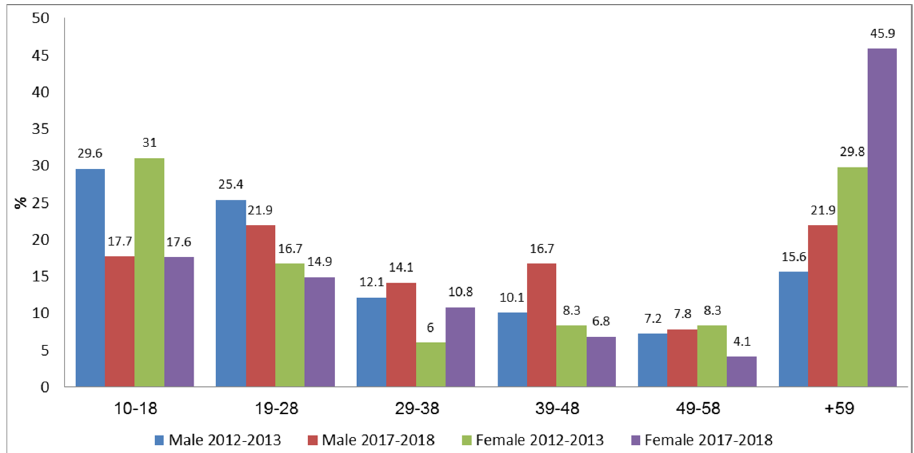
Figure 2. Distribution of traumatic injury according to age and gender. Table 1. Pre-hospital team